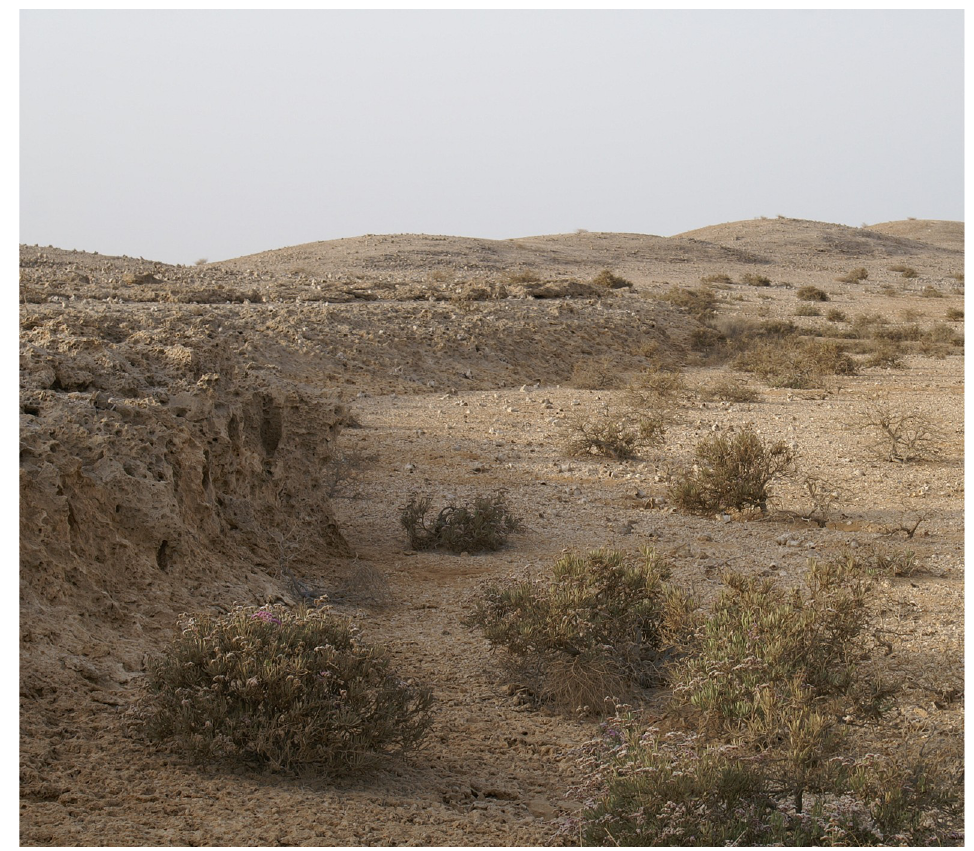
Fig 4. Shell mounds on the west side of the large inlet in Janaba West (Transect 1). Photograph taken facing North- West, the low cliff at the edge of the coral platform on which the mounds sit is clearly visible on the left and represents the palaeoshoreline contemporaneous with the accumulation of the shell mounds. It is not nearly as deeply undercut as elsewhere because of erosion and partial collapse of the original overhang. It is probably the result of localised tectonic uplift that postdates the shell mounds and is not present on the palaeoshorelines elsewhere around this bay, for example in the Janaba central cluster. In the foreground are sandy deposits which extend out from the palaeoshoreline into what was originally a marine inlet. Photo by Geoff Bailey, March